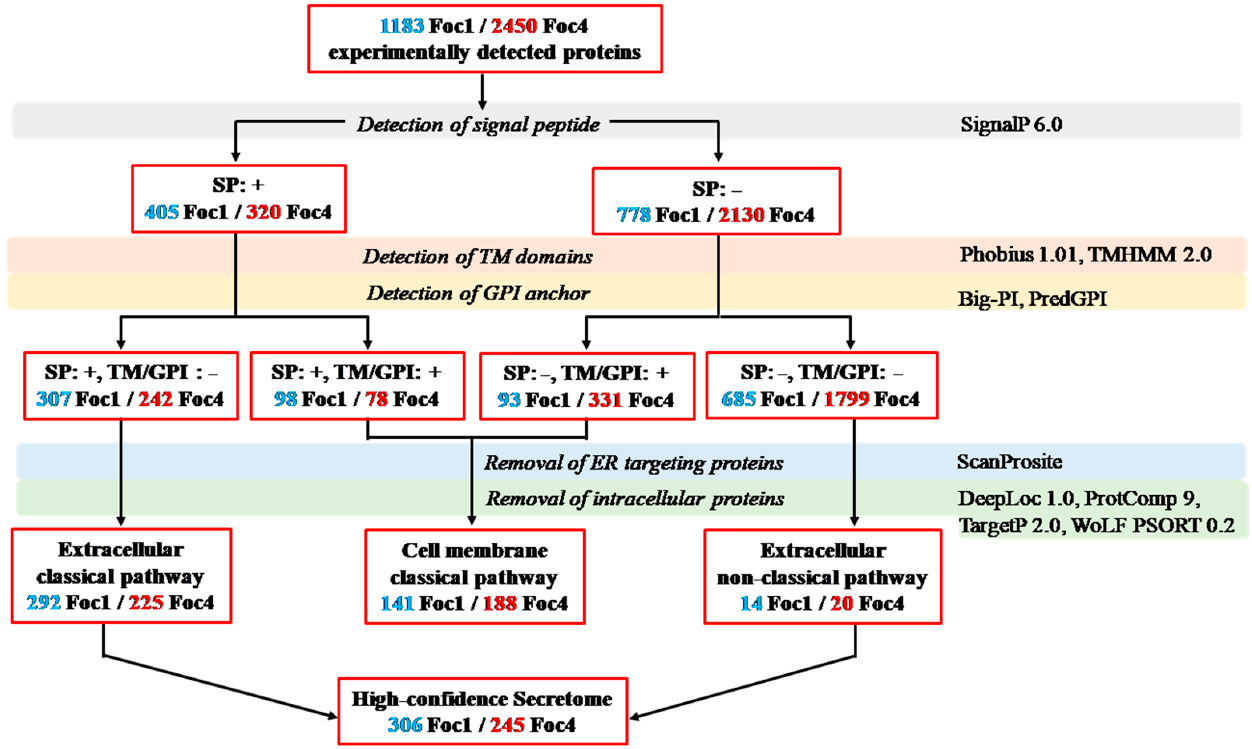
Figure 1. The bioinformatics pipelines used to predict the Foc1 and Foc4 secretomes.